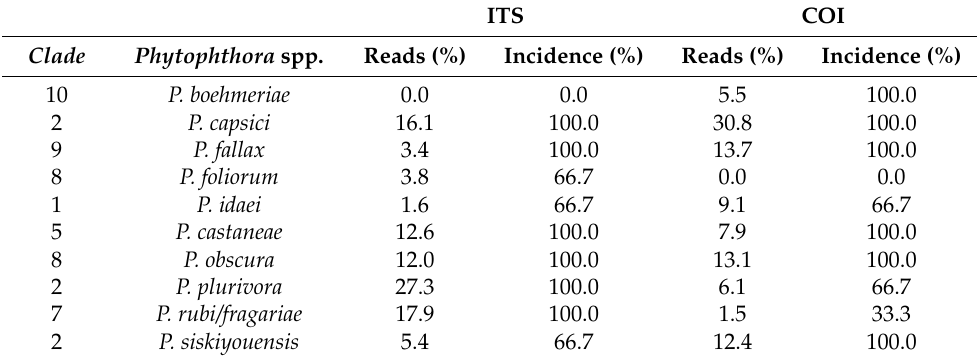
(Table 2). No false positive Phytophthora species for any of the control reactions were detected. For ITS, and concerning the percentage of reads assigned to each Phytophthora spp., five Phytophthora spp. represented more than 85.8% of reads (from 12.0 to 24%), including P. capsici , P. castaneae , P. obscura , P. plurivora and P. rubi , whereas the remaining Phytophthora spp. represented 14.2% of reads only (from 1.6 to 5.4% of reads). For COI, five Phytophthora spp. represented more than 79.0% of reads, including P. capsici , P. fallax , P. idaei , P. obscura and P. siskiyouensis (from 9.1 to 30.8%), whereas the remaining Phytophthora spp. represented the remaining 21% of reads (from 1.5 to 7.9%) (Table 2). Table 2. Frequency of reads assigned to each Phytophthora sp. in the control samples and incidence of detection. ITS COI Clade Phytophthora spp. Reads (%) Incidence (%) Reads (%) Incidence